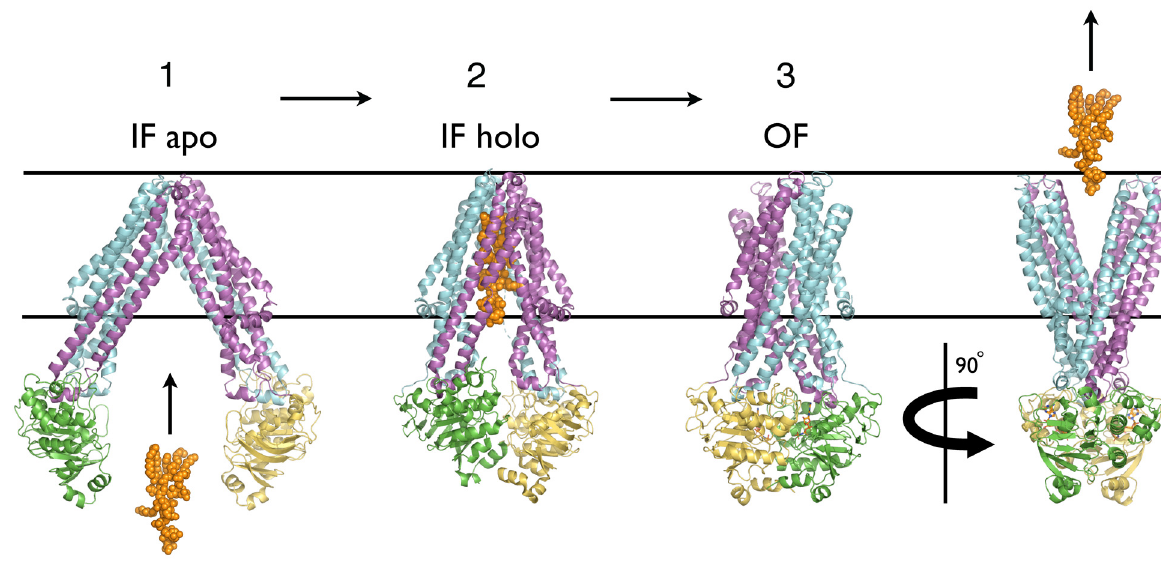
Figure 2. Switch Model for ABC Exporters. Alternating access Switch Model for the function of an ABC exporter. Structures of orthologues of the bacterial lipid A exporter MsbA. (i) PDB 6BL6 [32] Salmonella typhimurium ; (ii) PDB 6BPL [33] E. coli ; and (iii) PDB 3B6O [34] Salmonella typhimurium . MsbA is shown in cartoon ribbon representation with one protomer colored magenta and yellow and the other cyan and green for the TMD and NBD, respectively. Parallel lines represent the extracellular (upper) and intracellular (lower) membrane boundaries. Lipid A ligand is shown in atomic sphere representation and colored orange, ATP in is stick form. ( Stage 1 ) Unliganded transporter in inward ‐ facing resting state. ( Stage 2 ) Lipid A ligand binds to inward ‐ facing TMDs. ( Stage 3 ) ATP binding to each NBD induces tight dimerization of NBDs and transition of TMDs from inward ‐ to outward ‐ facing conformation, as the substrate is released to the extracellular space. Two orthogonal views of ( Stage 3 ) are shown to illustrate both NBD dimerization and outward facing conformation of TMDs.